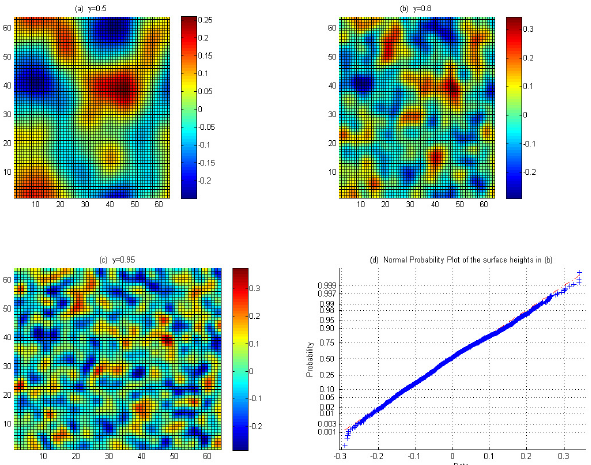
Figure 12. Rough surfaces on [ − 6 , 6] × [ − 5 , 5] mm 2 with σ = 0 . 1: (a) γ = 0 . 5; (b) γ = 0 . 8; (c) γ = 0 . 95; (d) The normal plot of the surface heights in